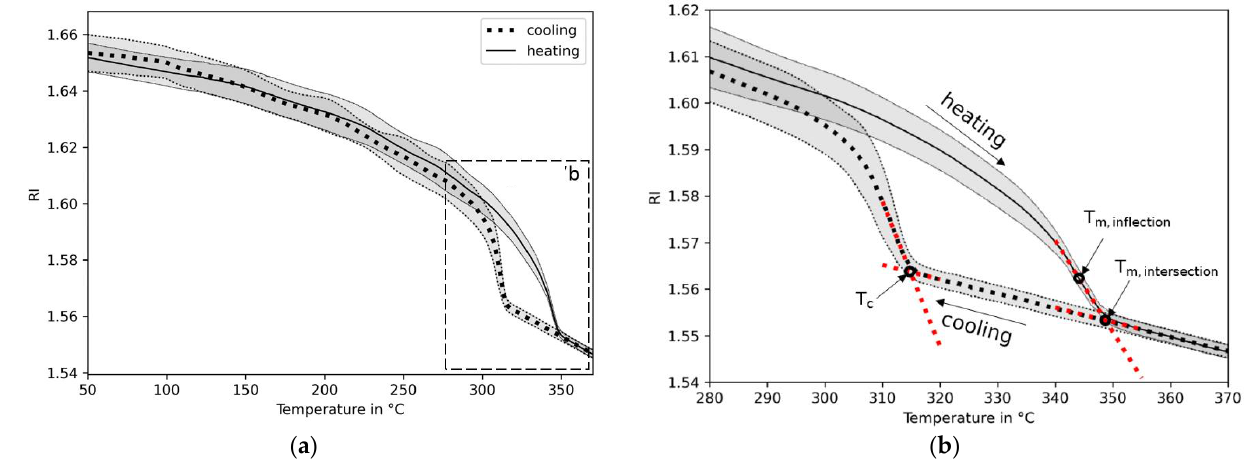
Figure 7. Temperature-dependent refractive indices (RI) derived from the FRS of PEEK ( a ) and focusing on the differences in their paths of the cooling and heating process, including the crystallization (Tc) and melting temperature (Tm, inflection; Tm, intersection) ( b ). The cooling rate displayed is 5 °C/min.